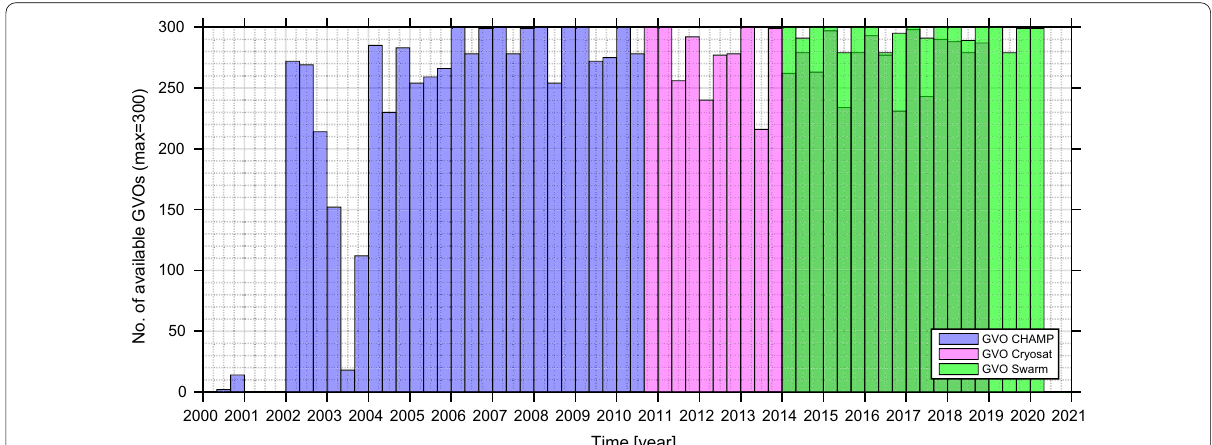
Fig. 1 The available number of GVOs for each epoch during CHAMP (purple), CryoSat-2 (pink) and Swarm